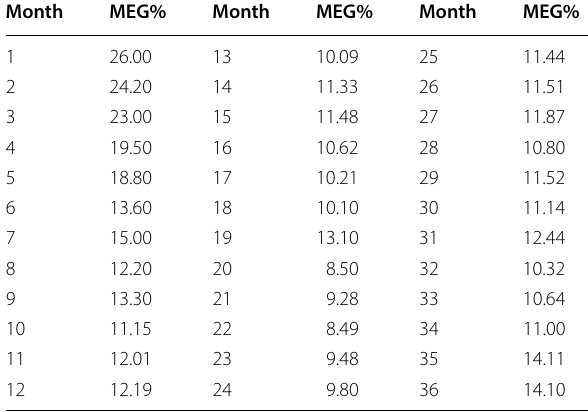
Table 8 MEG loading in lean amine after routed to the bottom of 105-D-201 in the condensation unit instead of routing to the amine flash drum